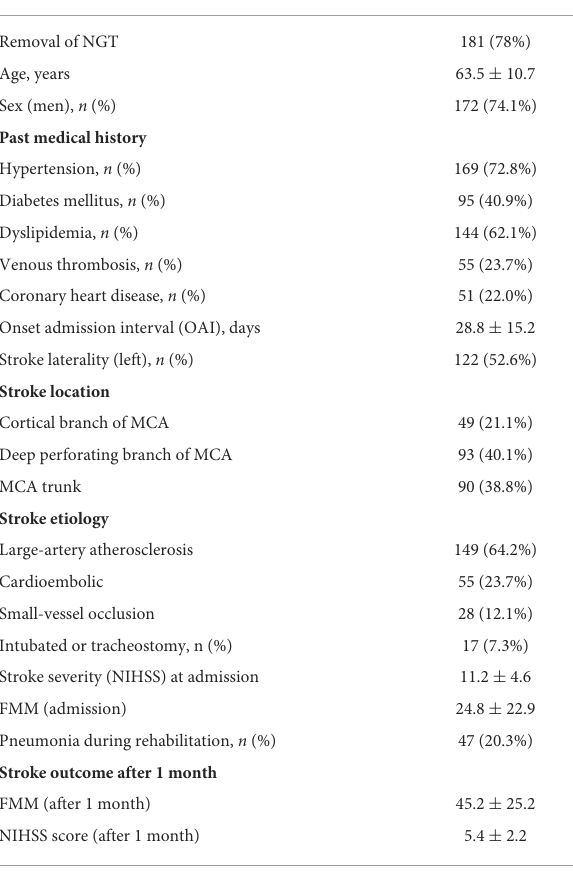
TABLE 1 Patients’